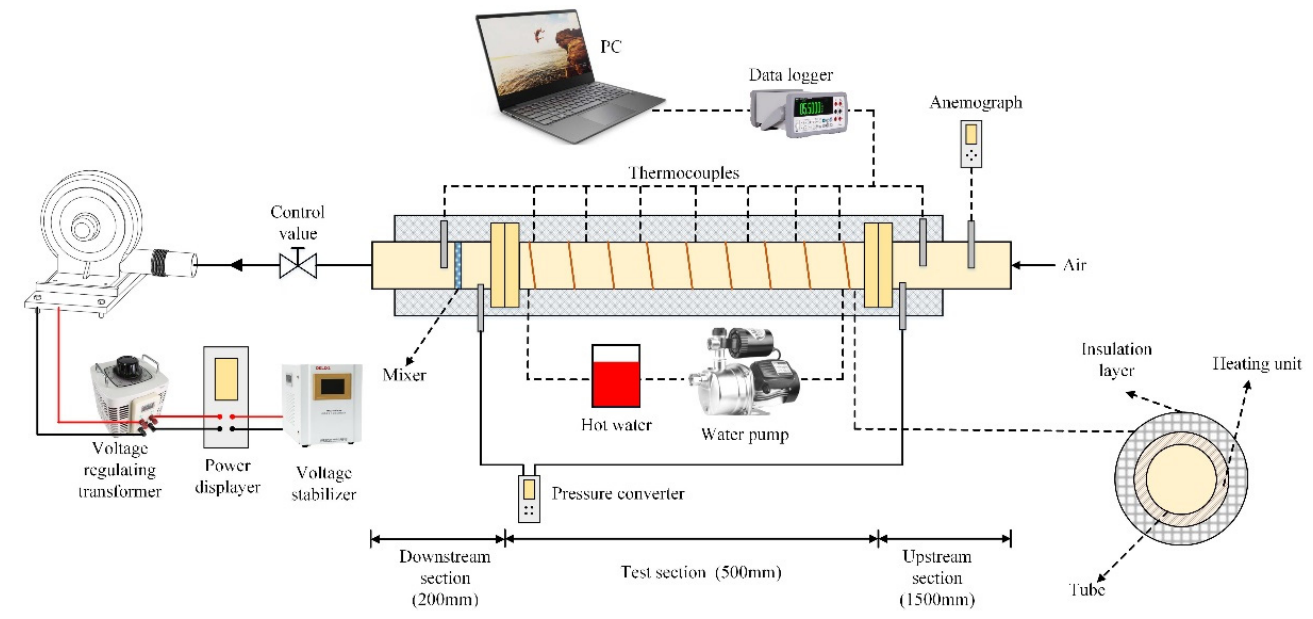
Figure 2. Schematic of the experiment facility.